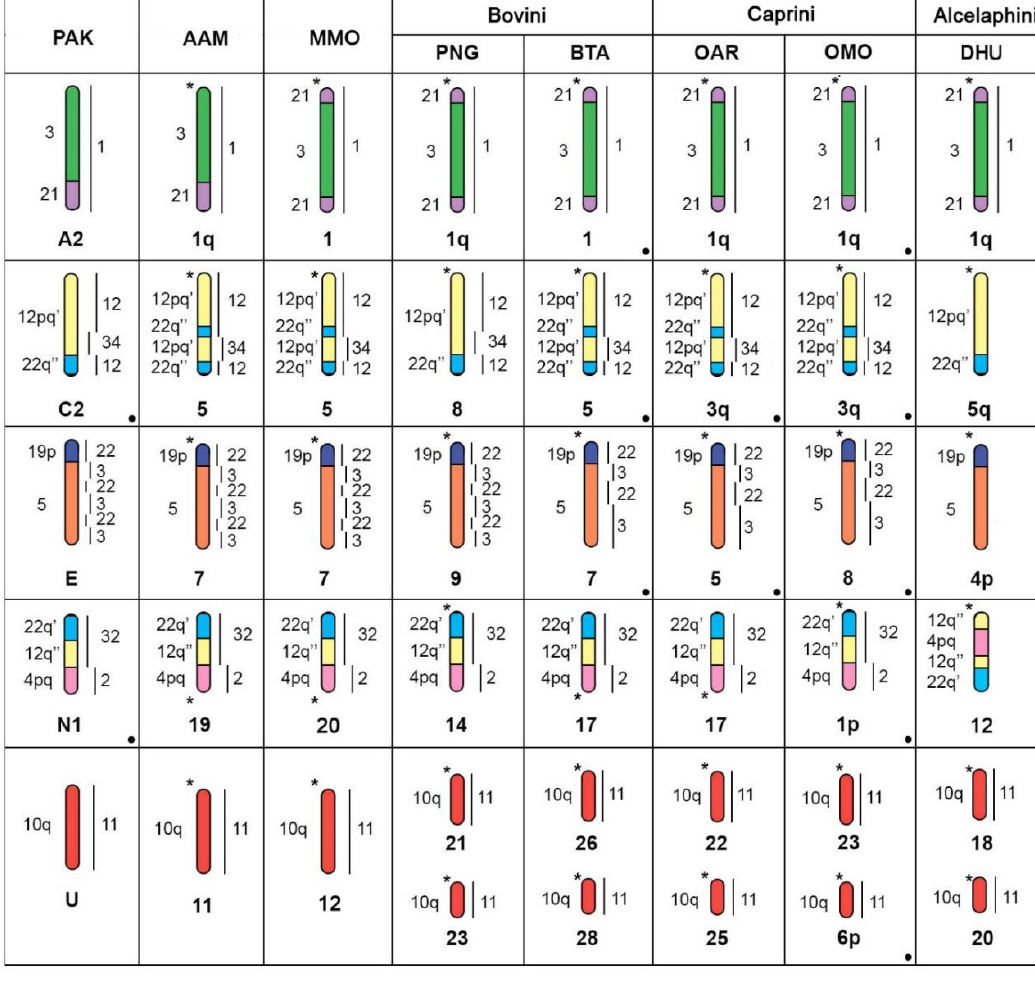
Figure 4. A scheme depicting chromosome homologies of pecoran species to the ancestral karyotype chromosomes (PAK) [5] with human homologies on the left and dromedary on the right. Presented species include AAM ( Antilocapra americana ) [5], MMO ( Moschus moschiferus ) [30], and representatives of di ff erent Bovidae tribes: PNG ( Pseudoryx nghetinhensis ) [5], BTA ( Bos taurus ) [6] (Bovini), OAR ( Ovis aries ) [10], OMO ( Ovibos moschatus ) (Caprini), DHU ( Damaliscus hunteri ) [11] (Alcelaphini). Centromere positions are shown by an asterisk. New data obtained in this study are marked by a black circle in cell corners.